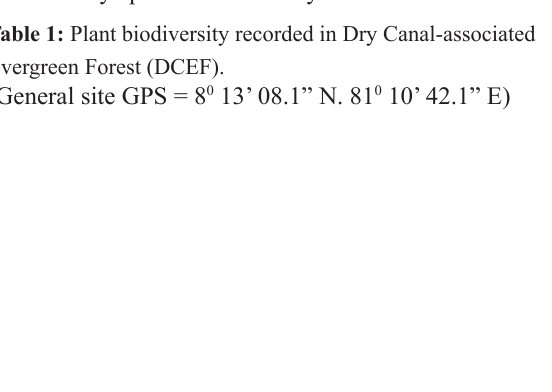
Table 1: Plant biodiversity recorded in Dry Canal-associated Evergreen Forest